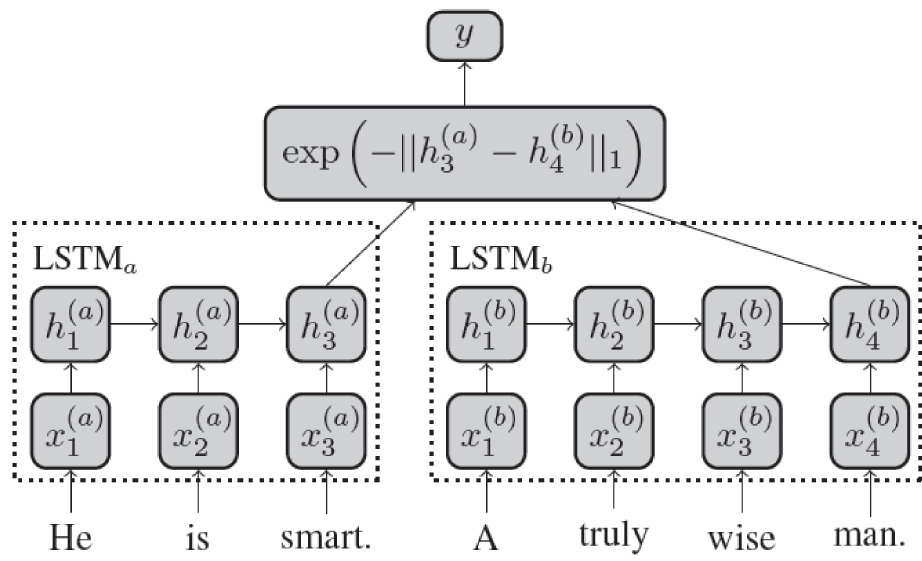
Figure 2. Deep belief networks architecture